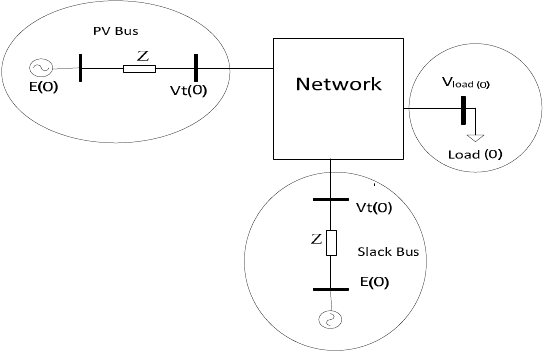
Figure 1. The single power network diagram including a PV.